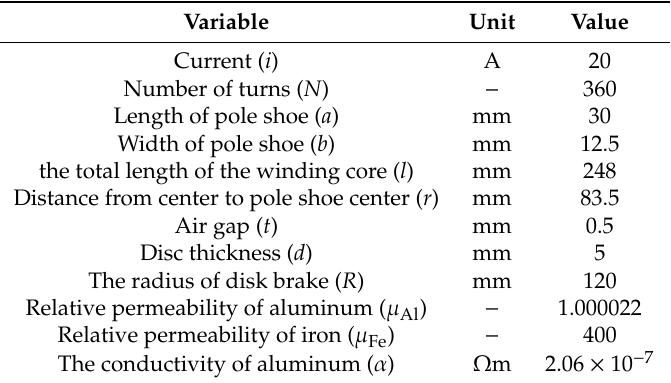
Table 1. Eddy Current Brake design